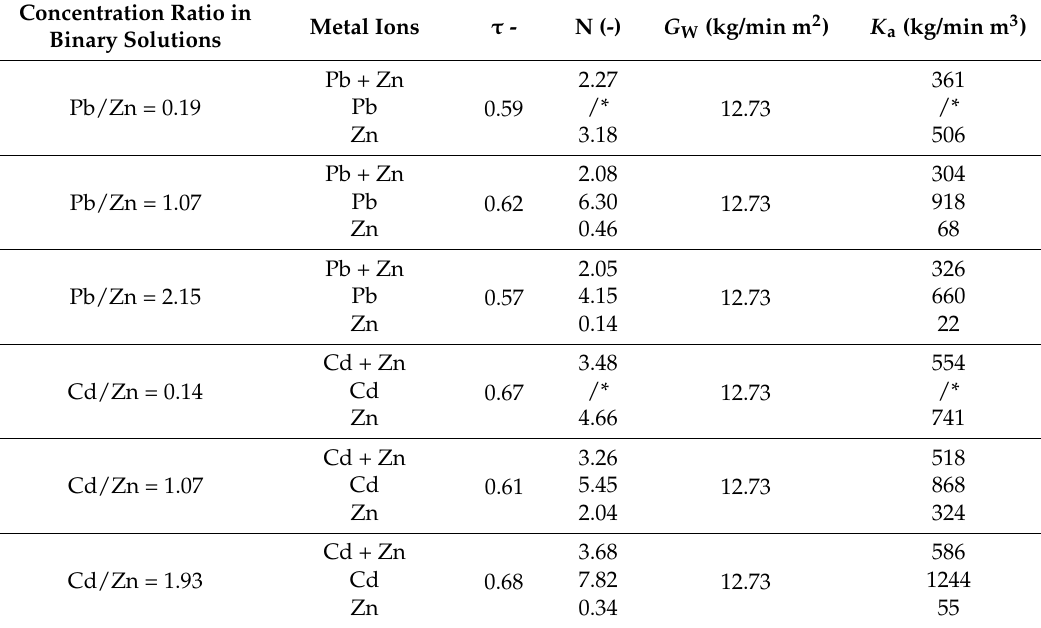
Table 3. The mass transfer parameters for the (Pb + Zn) and (Cd + Zn) binary systems. Concentration Ratio in Binary